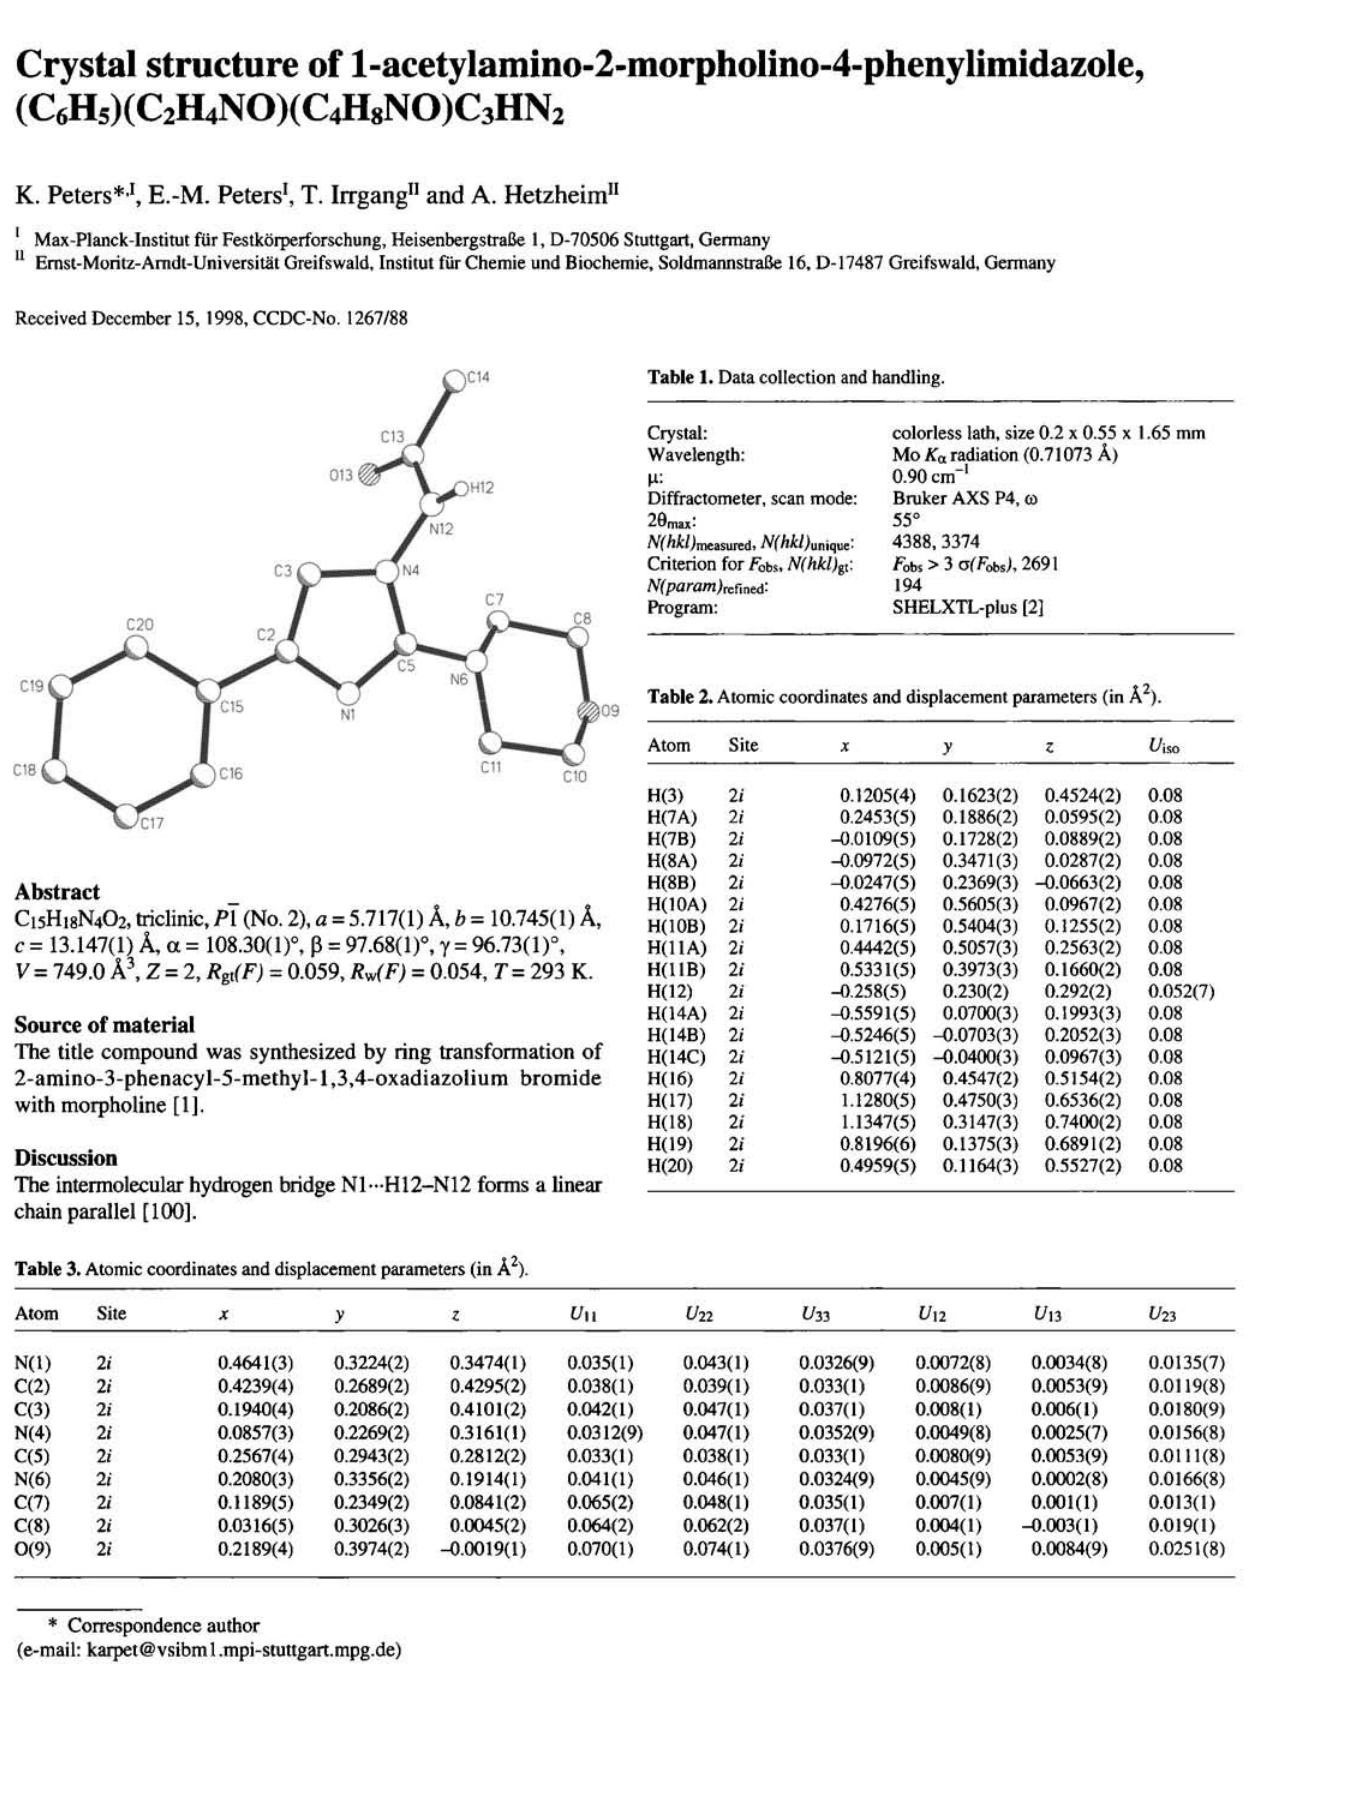
Table 1. Data collection and handling. Crystal: